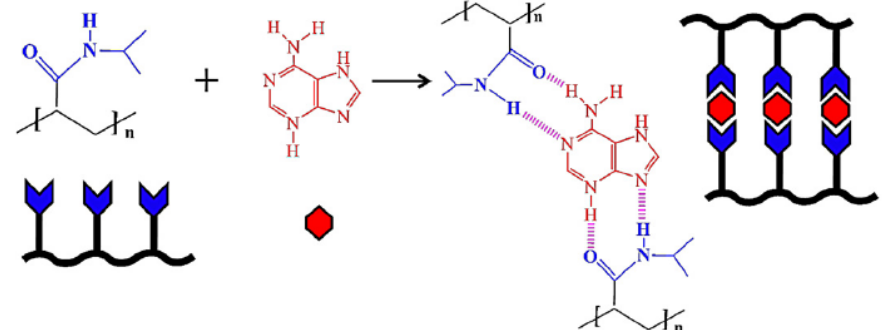
Figure 2. Representation of the supramolecular structure formed from the complexation of PNIPAAm and adenine through a nucleobase-like hydrogen bonding (NLHB) interactions. Reprinted (adapted) with permission from